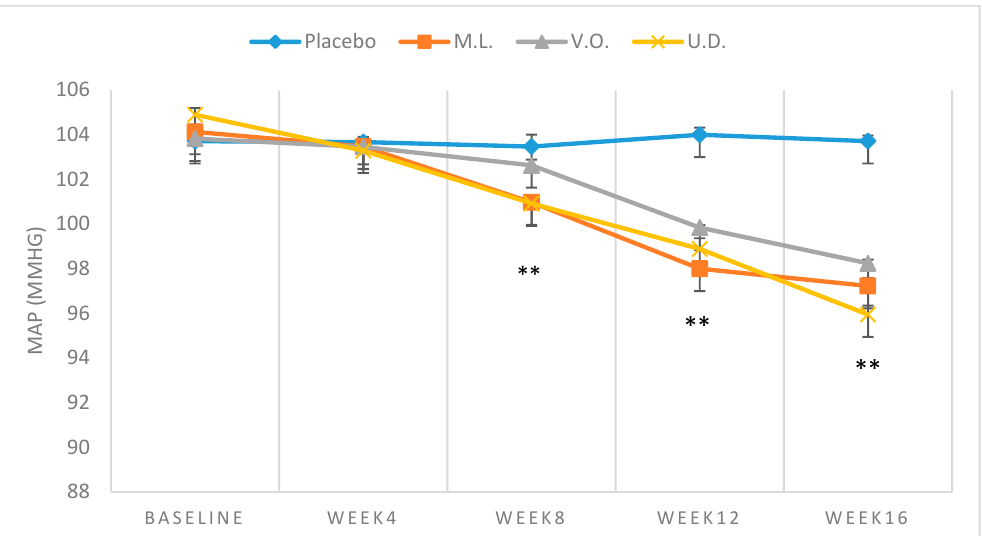
Figure 3. Means ± SD of MAP, measured over 16-week intake of 300 mL / day of M. longifolia (M.L.), V.odorata (V.O.) and U. dioica (U.D.) in mild hypertensive subjects. ** p < 0.01 (M.L. and U.D. compared to Placebo at week 8 and M.L., V.O., and U.D. compared to Placebo at weeks 12 and 16).